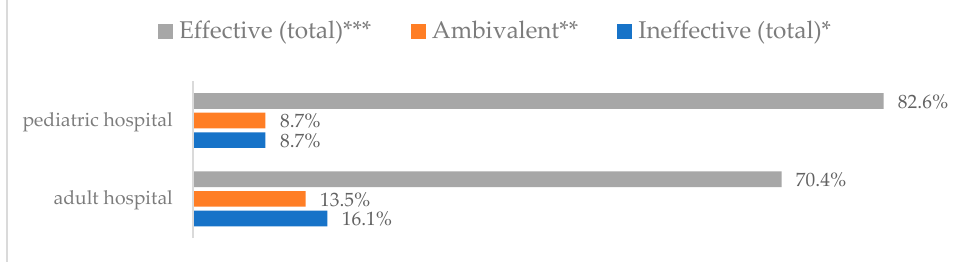
Figure 18. Avoiding contact with sick people to prevent influenza virus infection by type of hospital ( N = 905). * Sum of responses: completely ineffective, ineffective, rather ineffective; ** Response: neither ineffective nor effective; *** Sum of responses: rather effective, effective, completely effective.